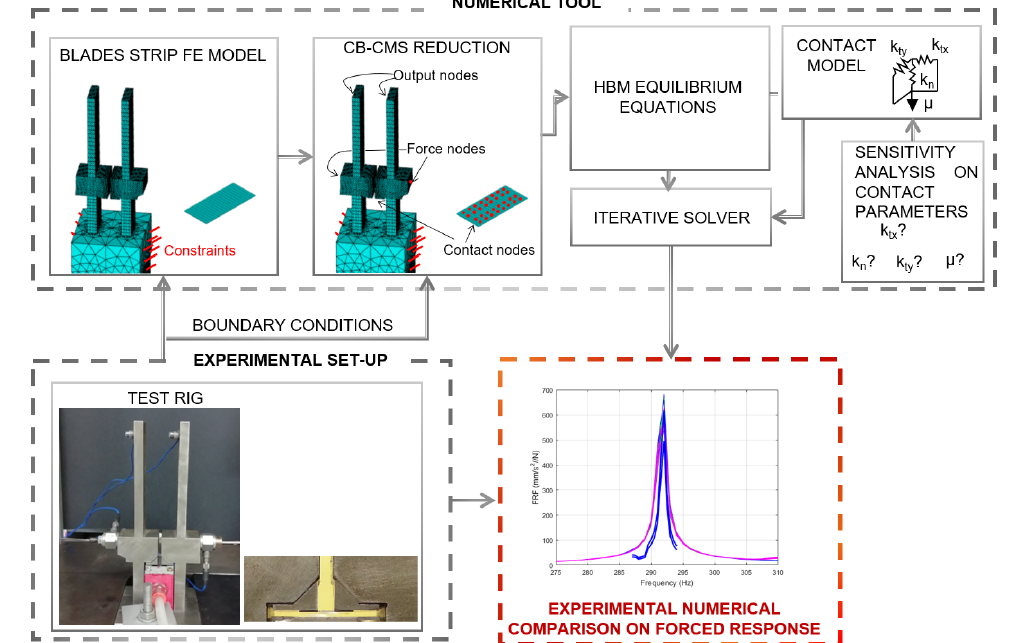
Figure 8. Functional scheme of the numerical simulation and its links to the experimental activity.